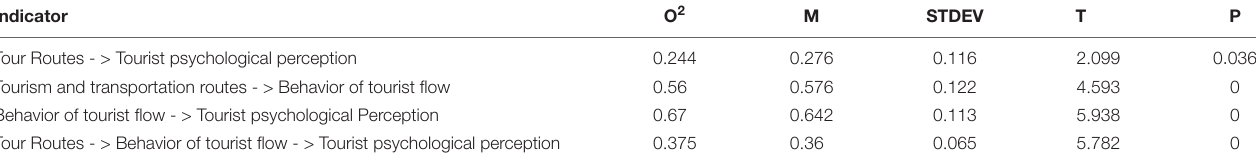
TABLE 5 | Results of the significance test of the path coefficients.